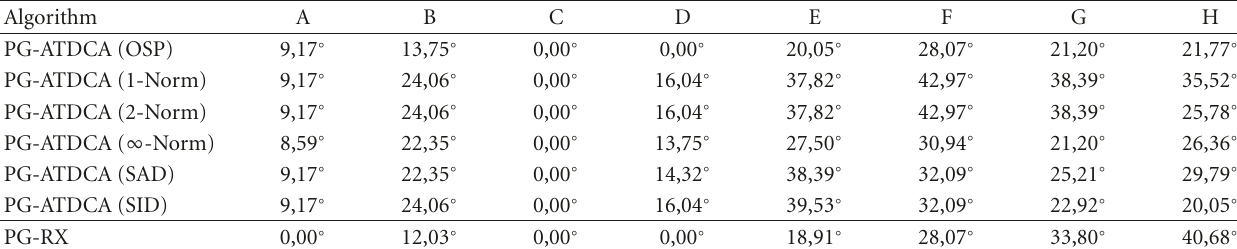
Table 2: Spectral angle values (in degrees) between target pixels and known ground targets for PG-ATDCA and PG-RX.